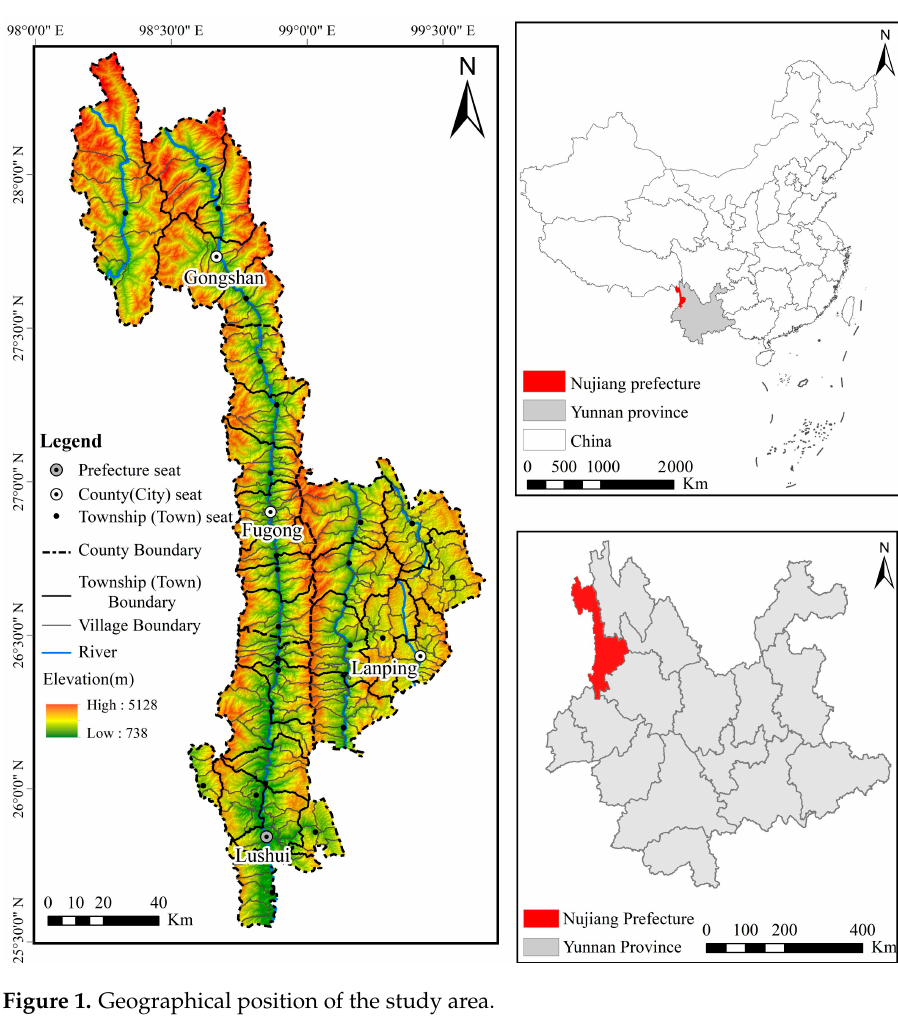
Figure 1. Geographical position of the study area.